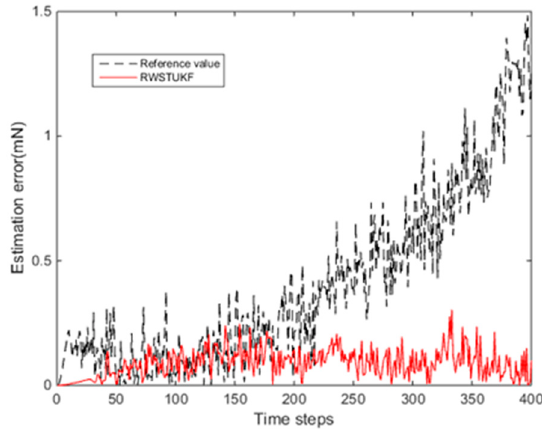
Figure 3. Estimation errors by both UKF and RWSTUKF under the error of model simplification.